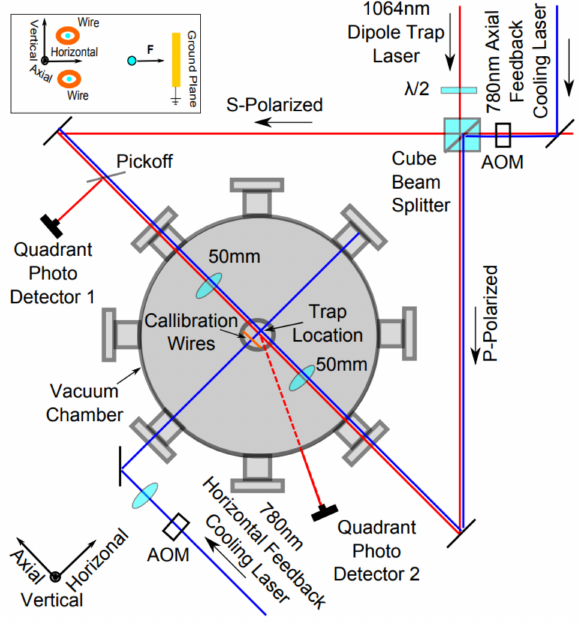
Figure 1. Optical path of the optical accelerometer from the group of Alexander et al.